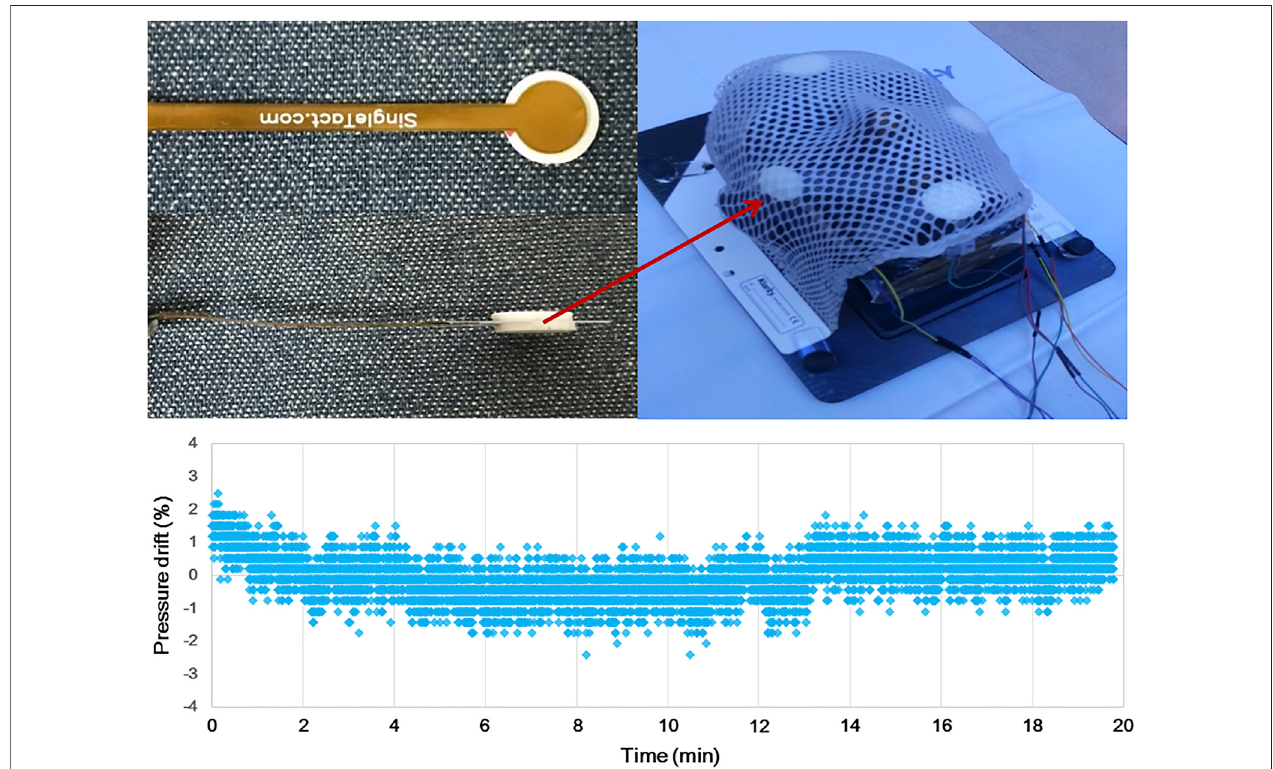
FIGURE 4 | Experimental setting for both the time effect and reproducibility test of the real-time TMCF monitoring system. A total of four sensors were attached to the face of a head phantom (forehead, both cheeks, and chin), and then, the phantom was immobilized by a thermoplastic mask.